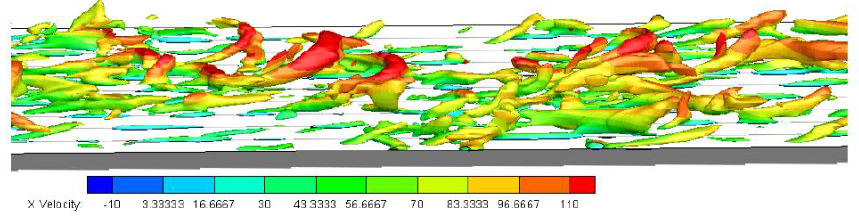
Figure 20. The λ isosurface of the flow velocity cloud picture of the triangular groove, λ = − 6.53 × 10 10 .